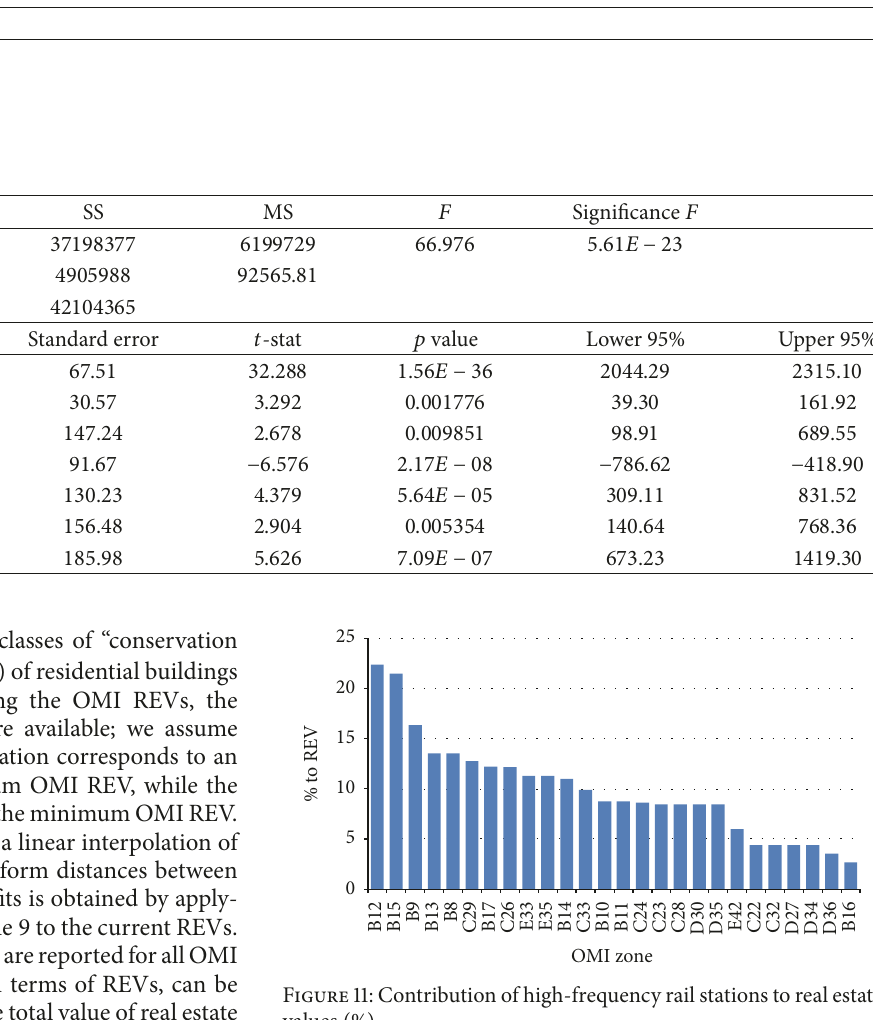
Table 7: Statistical tests for model 11.